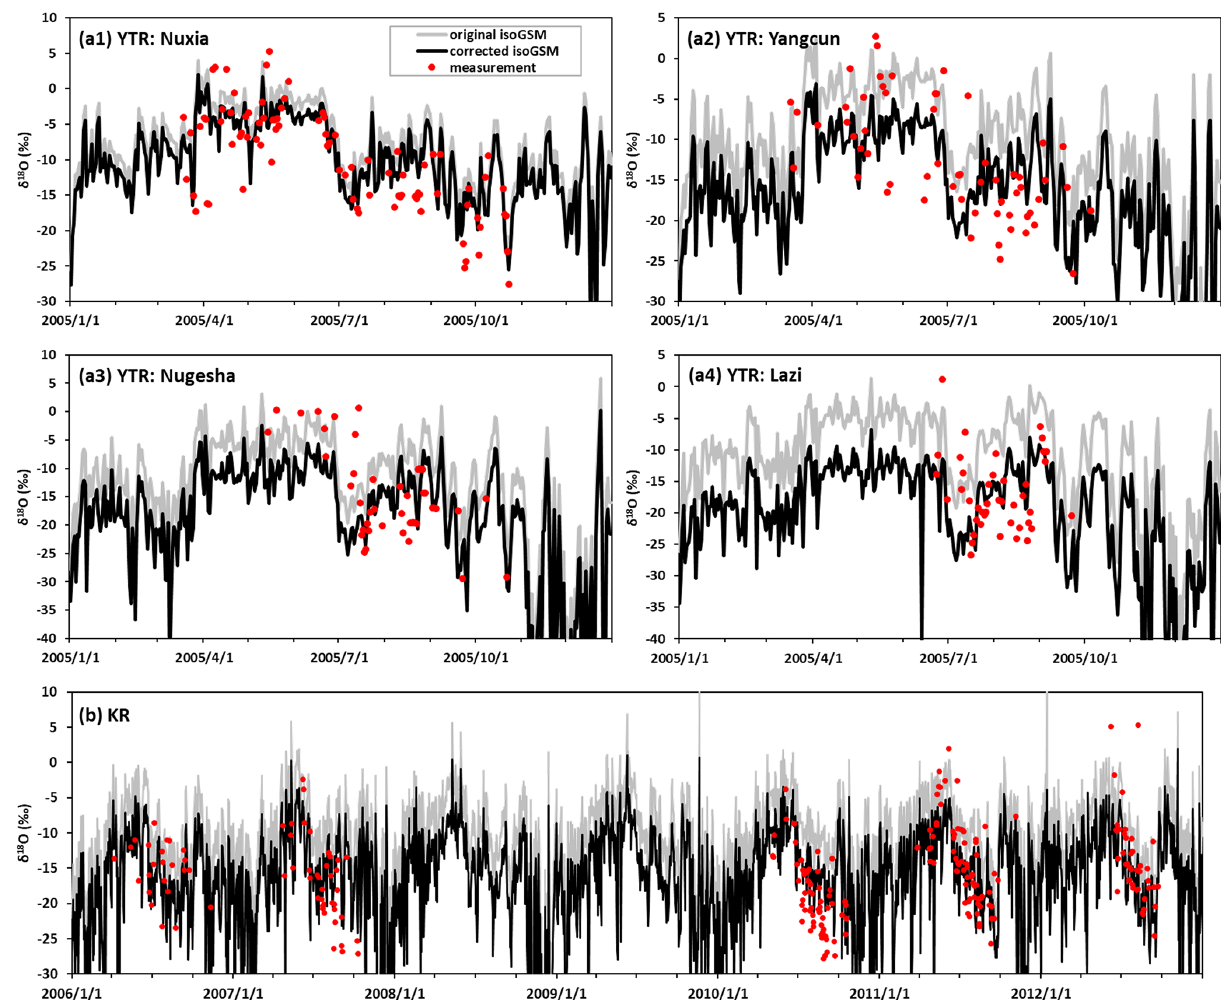
Figure 3. Temporal variations in the precipitation δ 18 O derived from measured and isoGSM data in the YTR basin (a1–a4) and KR catchment (b) .